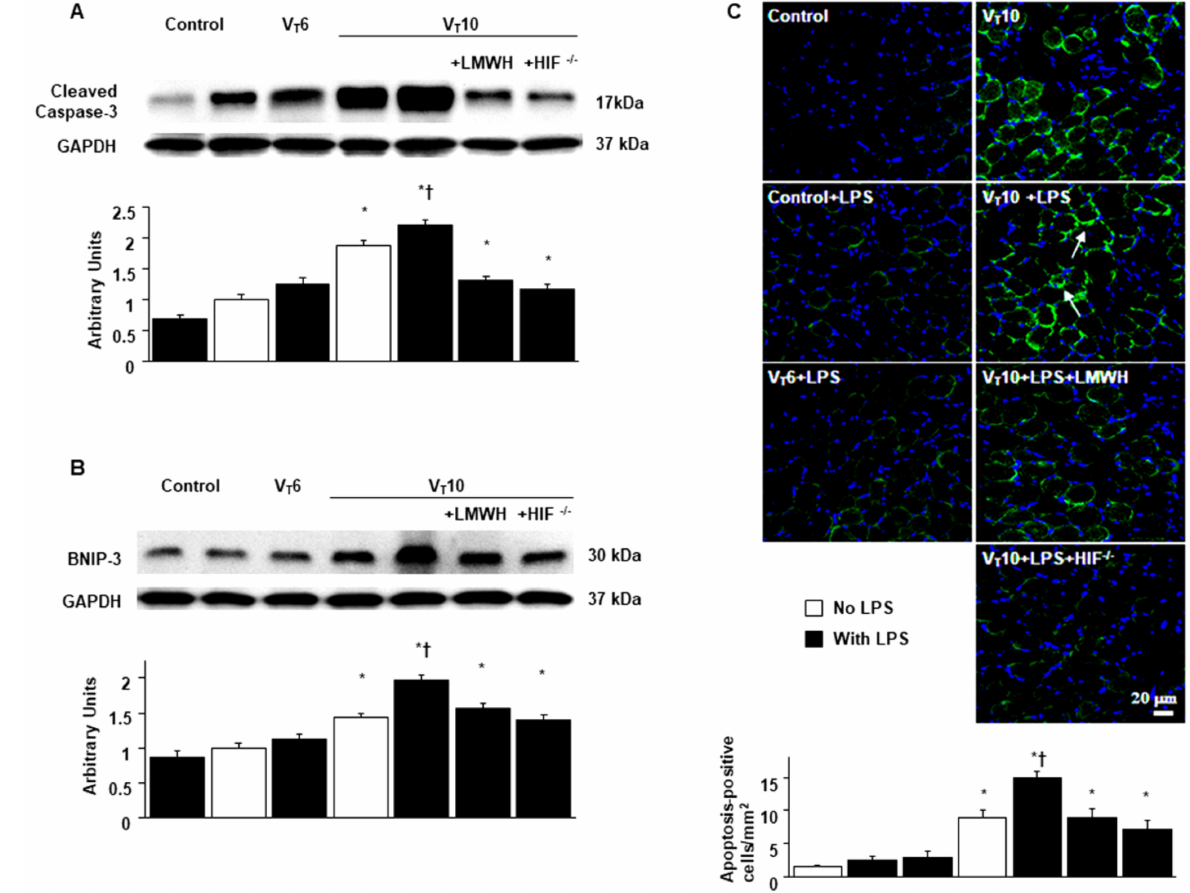
Figure 7. Suppression of endotoxin-augmented mechanical ventilation-induced expression of caspase-3 and BNIP-3, and muscle fiber apoptosis by enoxaparin and in HIF deficient mice. Caspase-3 ( A ), BNIP-3 ( B ), and GAPDH expression from the diaphragms of non-ventilated control mice and mice ventilated at a tidal volume of 6 mL/kg or 10 mL/kg for 8 h with or without LPS administration (n = 5 per group). Arbitrary units were expressed as relative cleaved caspase-3 and BNIP-3 activation (n = 5 per group). ( C ) Representative micrographs ( × 400) with TUNEL staining of paraffin diaphragm sections and quantification were from the diaphragms of non-ventilated control mice and mice ventilated at a tidal volume of 6 mL/kg or 10 mL/kg for 8 h with or without LPS administration (n = 5 per group). Enoxaparin, 4 mg/kg, was given subcutaneously 30 min before mechanical ventilation. Apoptotic cells are identified by arrows. A bright green signal indicates positive staining of apoptotic cells, and shades of dull green signify non-reactive cells. * p < 0.05 versus the non-ventilated control mice with room air; † p < 0.05 versus all other groups. Scale bars represent 20 µ m. BNIP- 3 = BCL2/adenovirus E1B 19 kDa protein-interacting protein 3; TUNEL = terminal deoxynucleotidyl transferase-mediated dUTP-biotin nick